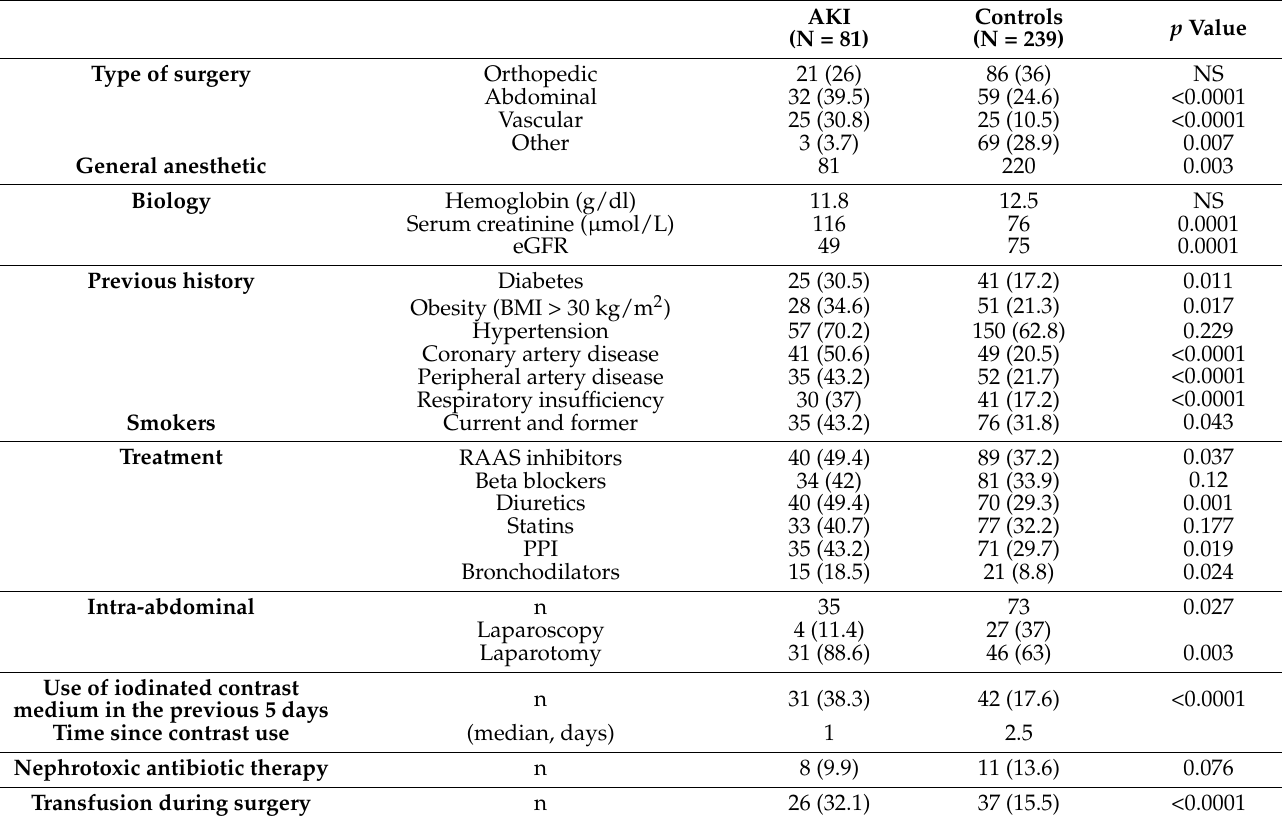
Table 2. Pre-operative characteristics of the study population.